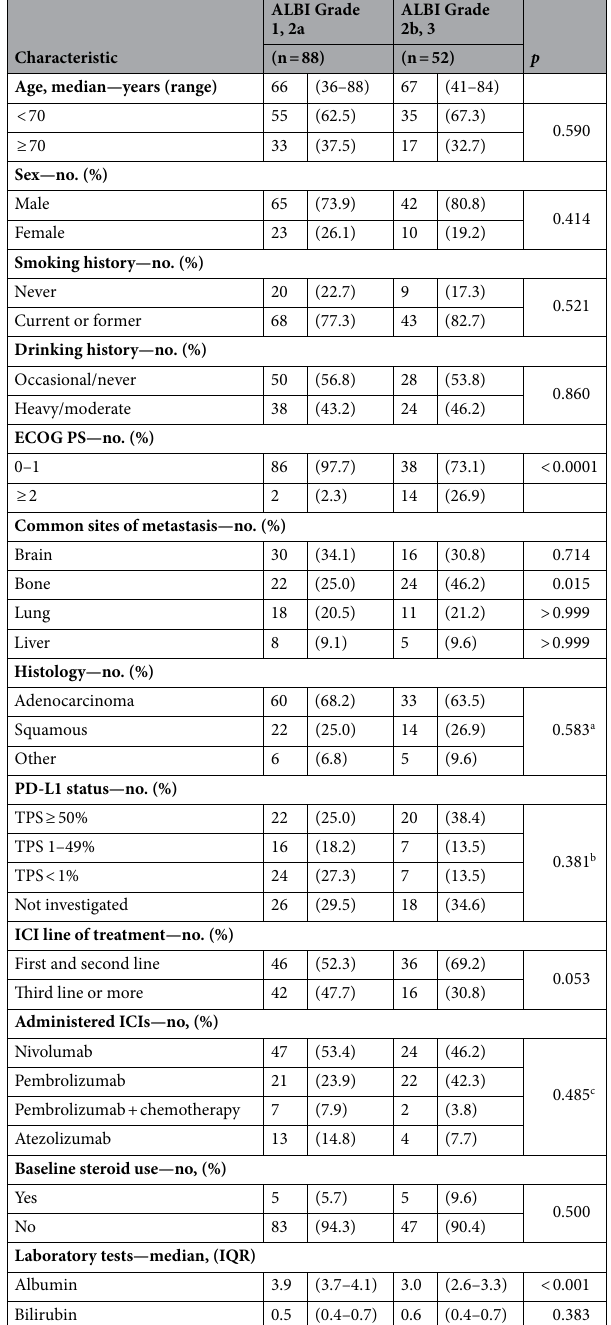
Table 2. Association between ALBI Grade and clinical variables. ALBI grade albumin–bilirubin grade, ECOG PS eastern cooperative oncology group performance status, PD-L1 programmed cell death ligand-1, ICI immune-checkpoint inhibitor, TPS tumor proportion score. a Adenocarcinoma versus all others, b PD-L1 TPS ≥ 1% versus all others, c Administered immune checkpoint inhibitors, Nivolumab versus all